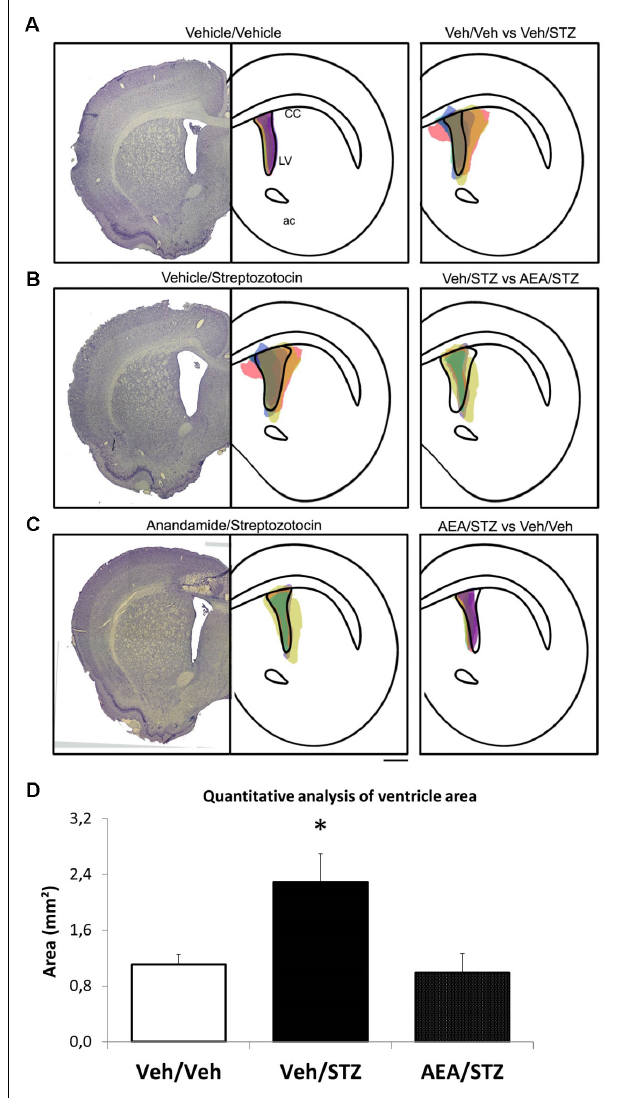
FIGURE 4 | Schematic representation and quantitative analysis of the cerebral ventricular area of Veh/Veh, Veh/STZ, and AEA/STZ animals. The left panel presents a representative histologic image of the lateral ventricle (LV) of the Veh/Veh groups in (A) , Veh/STZ in (B) , and AEA/STZ in (C) . The central panel represents schematically the shape of the histological figure from left, filled with colored spots corresponding to the ventricular area of each of the samples used in the respective groups ( n = 3–5). The right panel represents the central figure with the shape of the ventricle of one group overlapped with the ventricular area of the samples from another group ( A : Veh/Veh × Veh/STZ, B : Veh/STZ × AEA/STZ and C : AEA/STZ × Veh/Veh). (D) shows the quantitative analysis of ventricle area (mm 2 ), measured + 1.56 mm (anteroposterior) from bregma. ∗ p < 0.05, area values are different from Veh/Veh and AEA/STZ (one-way ANOVA, followed by Duncan’s post-test).